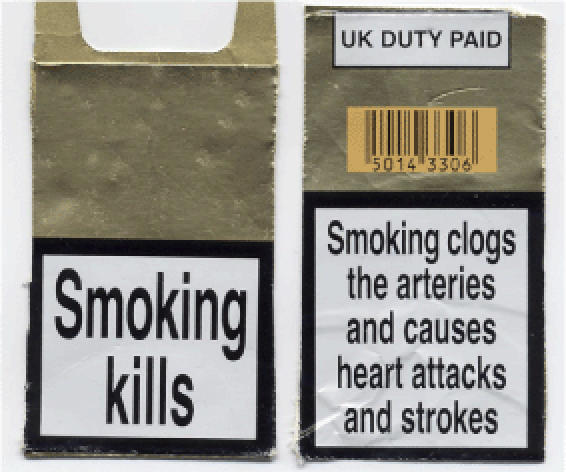
Doll and Hill's research led to an anti-smoking campaign in Britain that exemplified a behavioral model of chronic disease prevention(Photo: Adrian Pingstone)